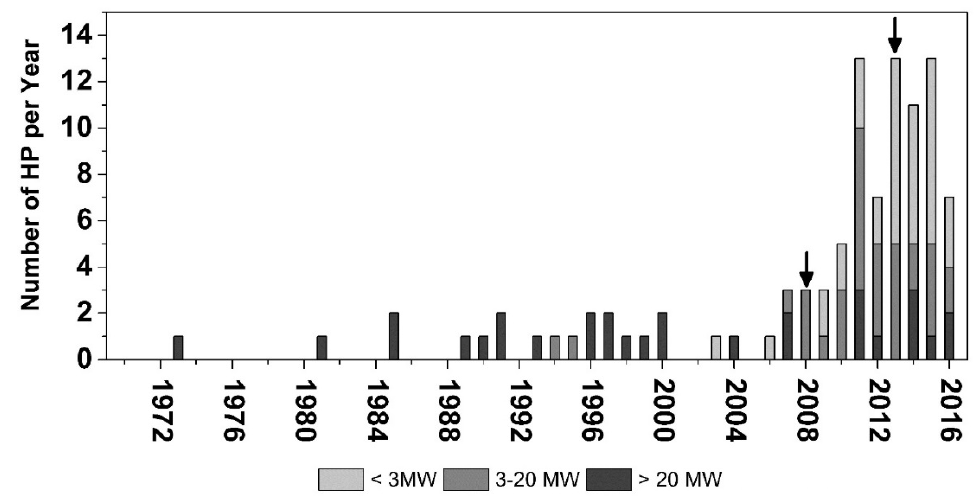
Figure 1. Installed hydropower plants (HP) in Chile between 1970 and 2016. Arrows indicate years of non-conventional renewable energy laws (NCRE) policy implementation.